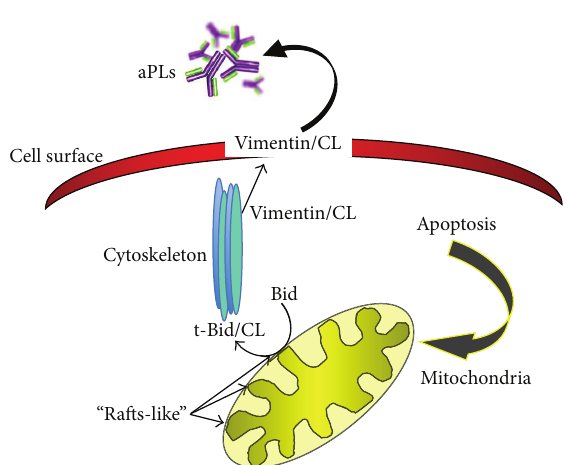
Figure 2: Schematic drawing depicting the intracellular traffic of cardiolipin and its metabolites following apoptotic